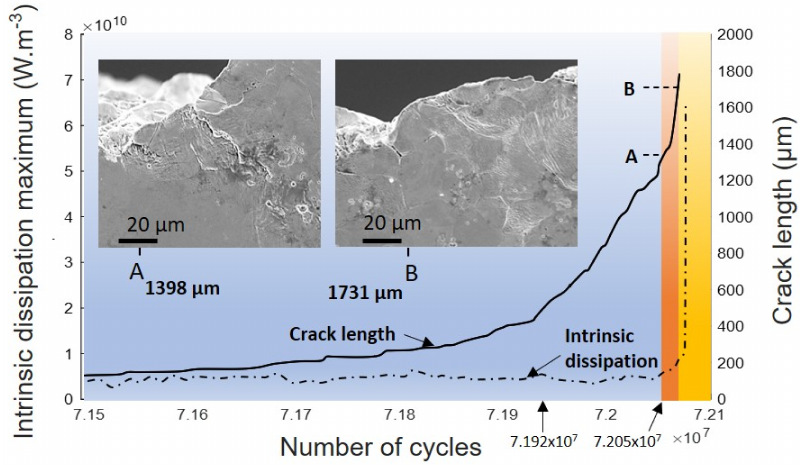
Figure 10. Evolution of the crack length based on the position of the maximum of intrinsic dissipation d 1 versus the number of cycles, and evolution of the level of d 1 versus the number of cycles.